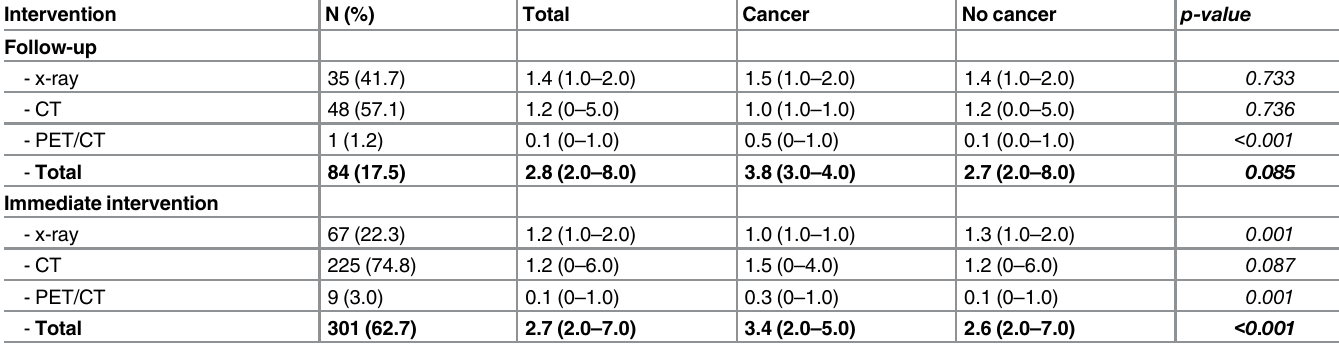
Table 6. Analysis of the number of imaging tests (mean, minimum, maximum) associated with the management of SPN for chest radiograph according to the management strategy and for patients with a final diagnosis of lung cancer and those without it.